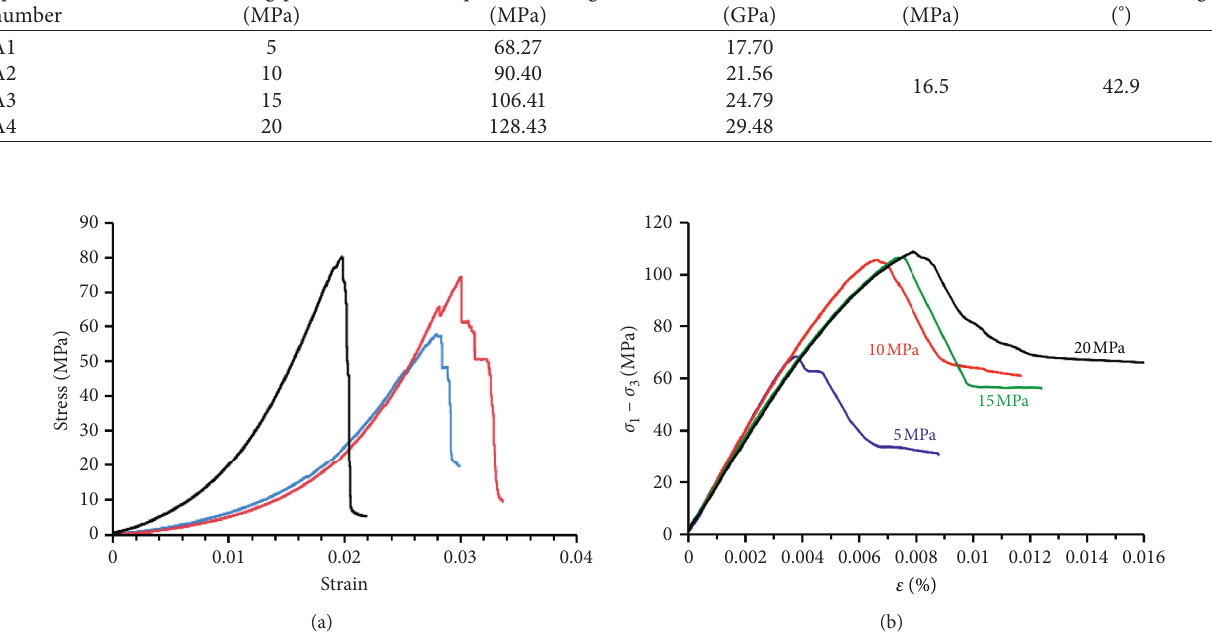
Figure 4: Stress-strain curves of mudstone. (a) Uniaxial compression. (b) Triaxial compression.